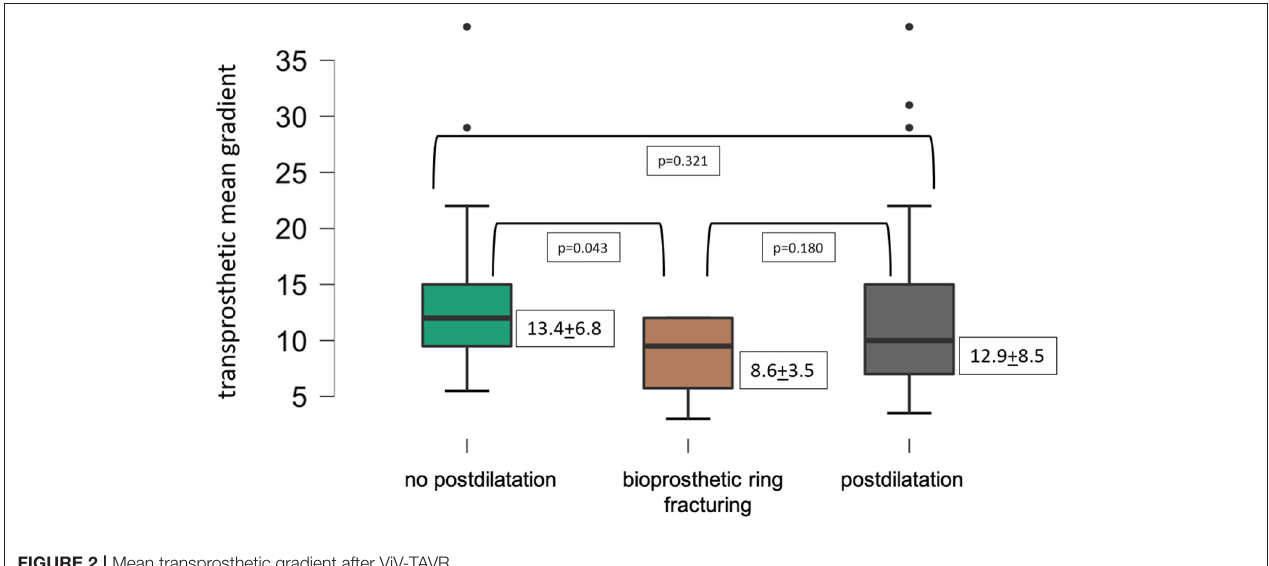
FIGURE 2 | Mean transprosthetic gradient after ViV-TAVR.